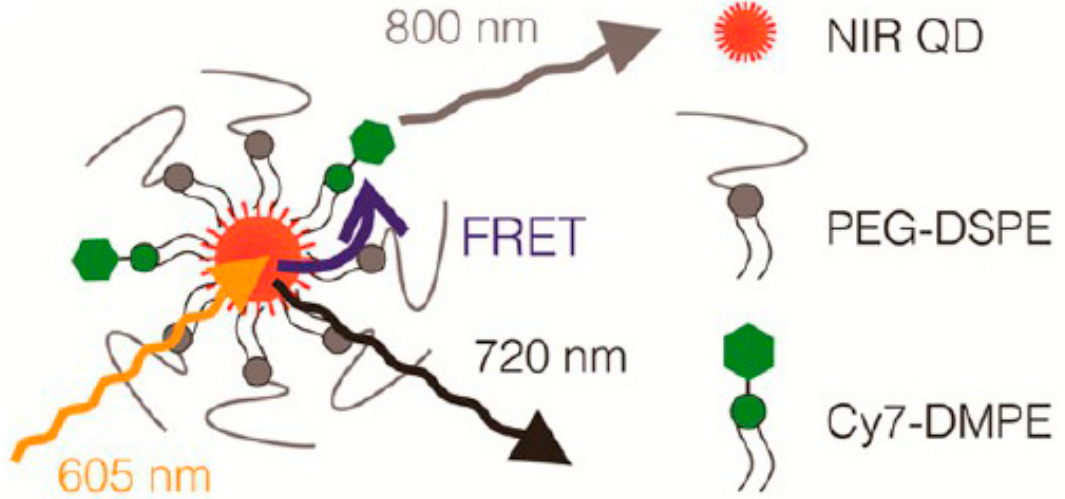
Figure 9. Schematic of lipid NPs that consists of a NIR QD core covered by a lipid coating (QD710-Cy7-PEG). Reproduced with permission from ref. [44]. Copyright 2013, American Chemical Society.